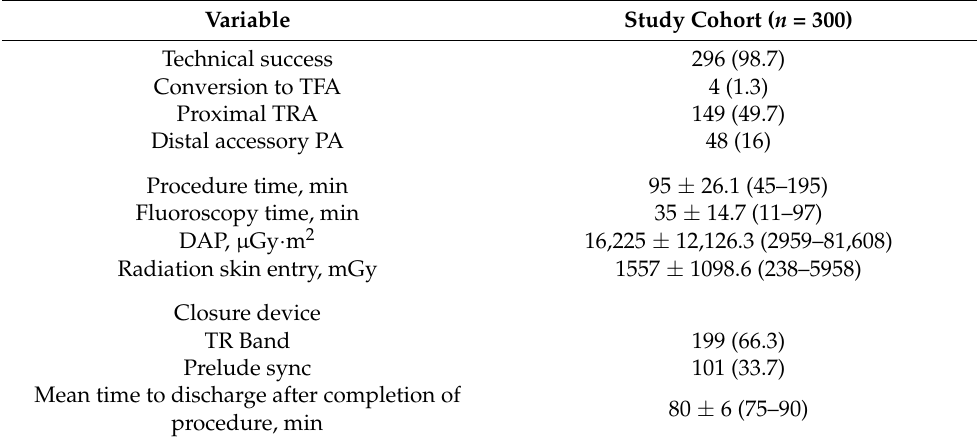
Table 2. Procedure characteristics of the study cohort.